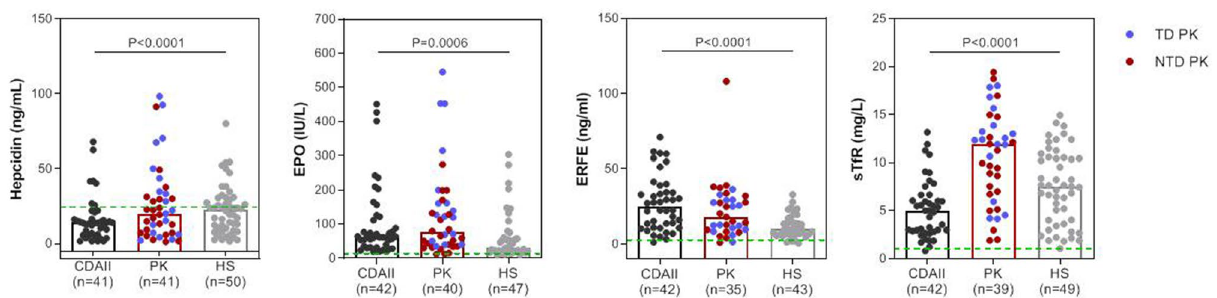
Figure 1. Distribution of hepcidin, EPO, ERFE, and sTfR in CDAII, PKD, and HS patients. Median values and range are reported. Green lines represent median control’s values. Transfusion-dependent (TD—blue filled circle) and not transfusion-dependent (NTD—red filled circle) PKD patients are shown. Kruskal–Wallis test; P-values and reference ranges for each variable are reported in Table